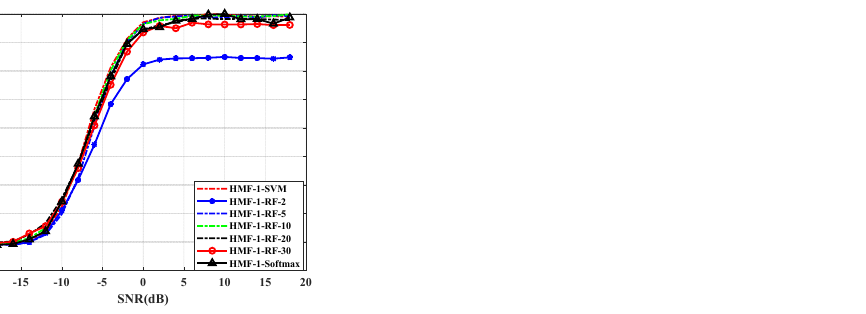
Figure 8. Classification accuracy comparison of HMF-I with different classifiers on RadioML2016.10 .a.